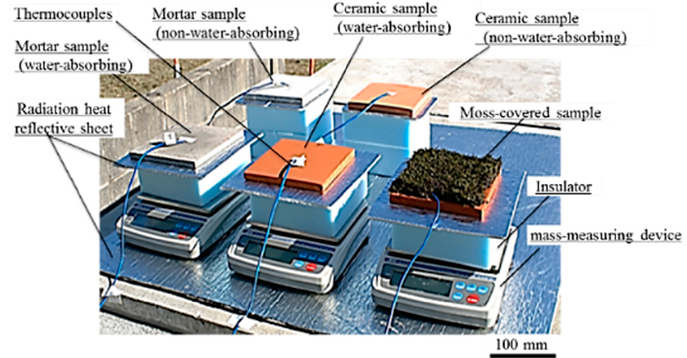
Figure 7. Measurement setup in field experiment.